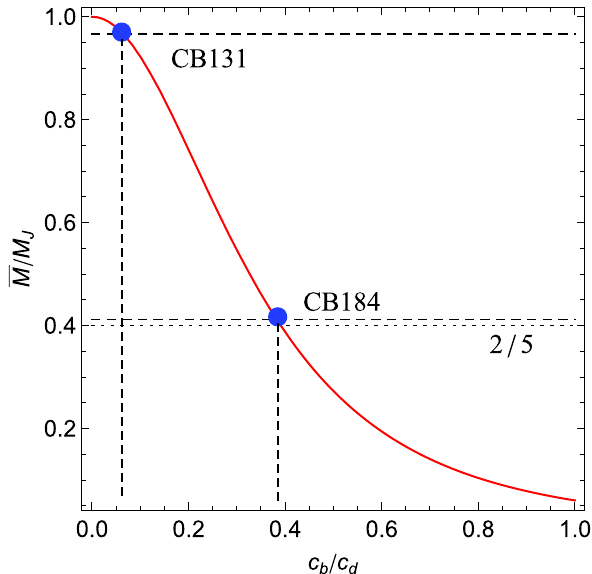
Fig. 2 ¯ M / M J as a function of c b / c d . We highlight the two extreme cases of Bok globules given in Table 2, namely CB131 and CB184. The horizontal dotted line represents the bound 2 / 5 given in Ref.